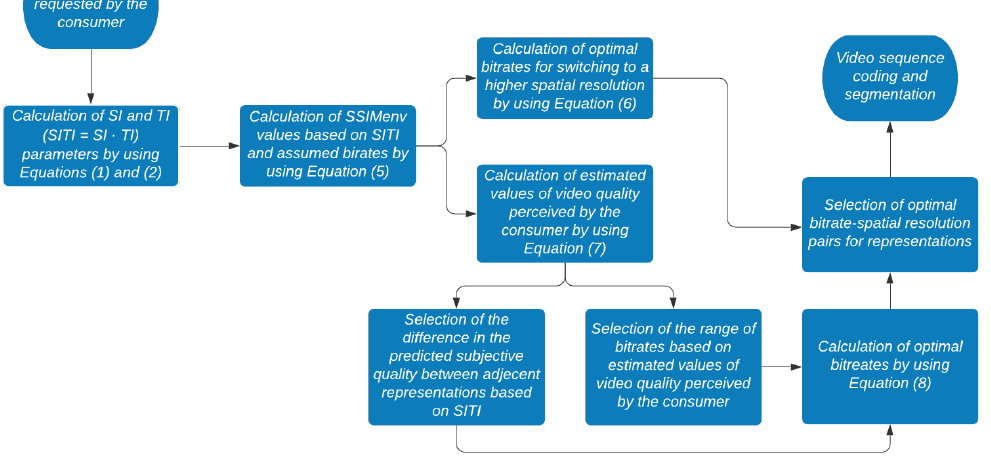
Figure 11. Selection of optimal representations diagram.